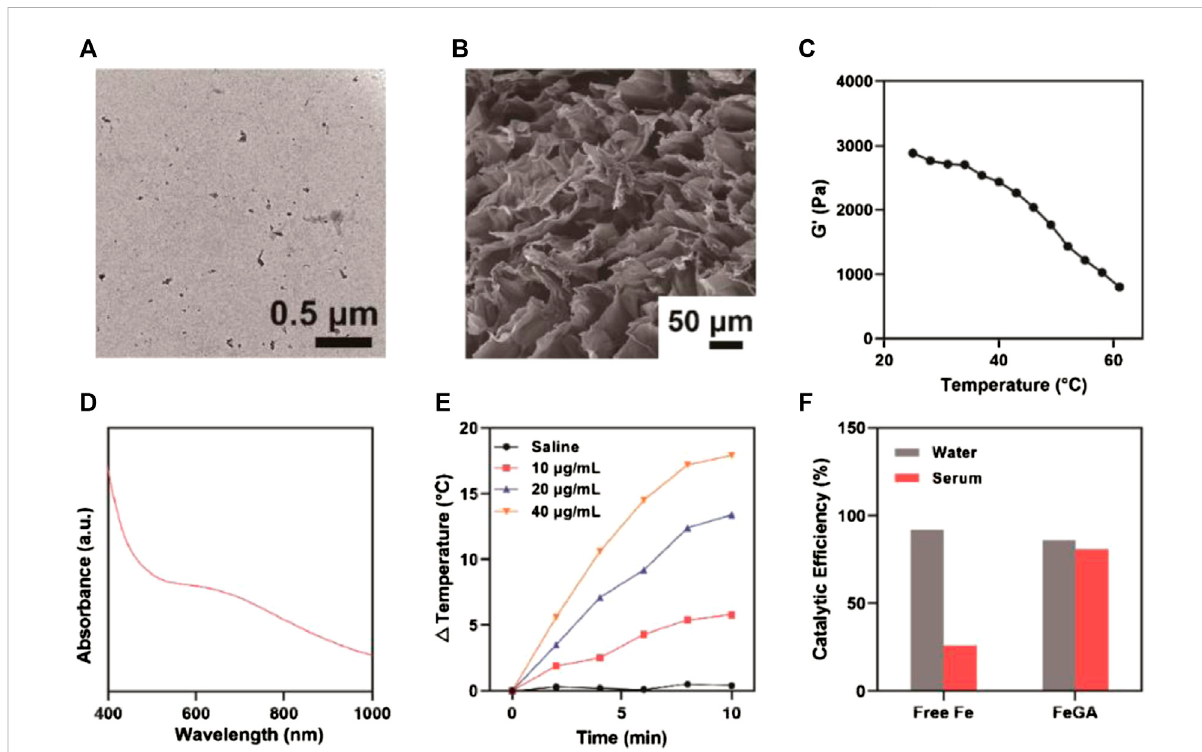
FIGURE 1 (A) Transmission electron microscopy image of FeGA-DOX. (B) SEM image of FeGA-DOX + AG. (C) Rheological behaviour analysis of FeGA- DOX + AG. (D) UV – vis absorption of FeGA-DOX. (E) The photothermal heating curve of FeGA-DOX at various concentrations. (F) The relative catalytic activity of free Fe 2+ and FeGA-DOX in water and